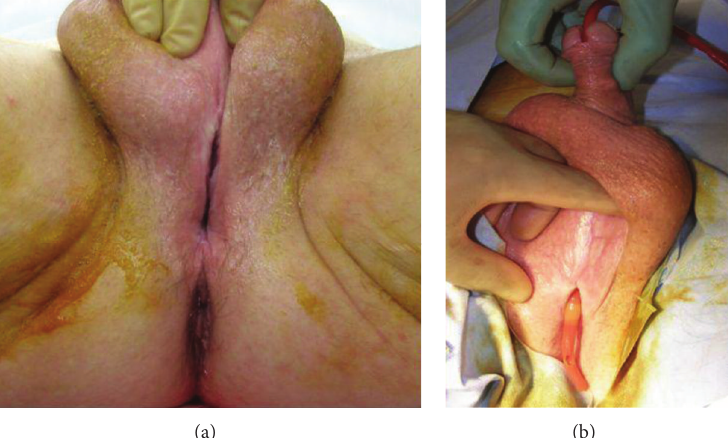
Figure 2: Intraoperative exam of the perineal defect (a). Coude-tipped foley catheter demonstrating the bulbar urethral-cutaneous fistula associated with the superior aspect of the perineal defect